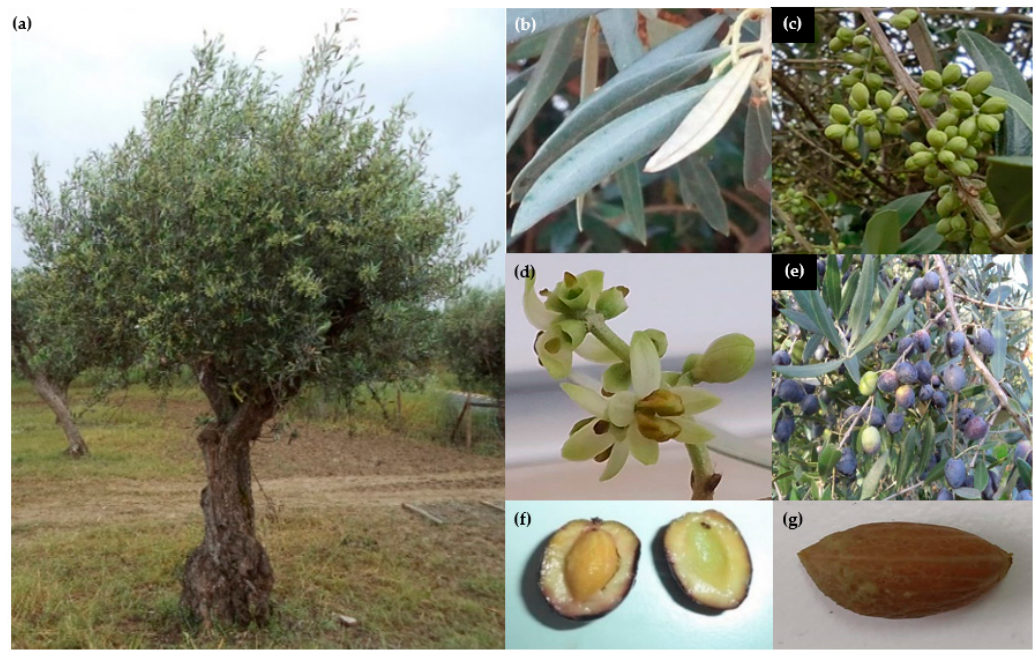
Figure 5. ‘Galega’ olive tree, the main Portuguese variety: ( a ) ‘Galega’ in a traditional olive orchard in Portugal; ( b ) Abaxial and adaxial surfaces of ‘Galega’ leaves; ( c ) Detail of the ‘Galega’ inflorescence before the pollination; ( d ) Flowers of ‘Galega’; ( e ) Drupes in ‘Galega’ tree; ( f ) Endocarp inside the drupe and the mesocarp; ( g ) Endocarp of ‘Galega.’ Photographs by Hélia Sales.